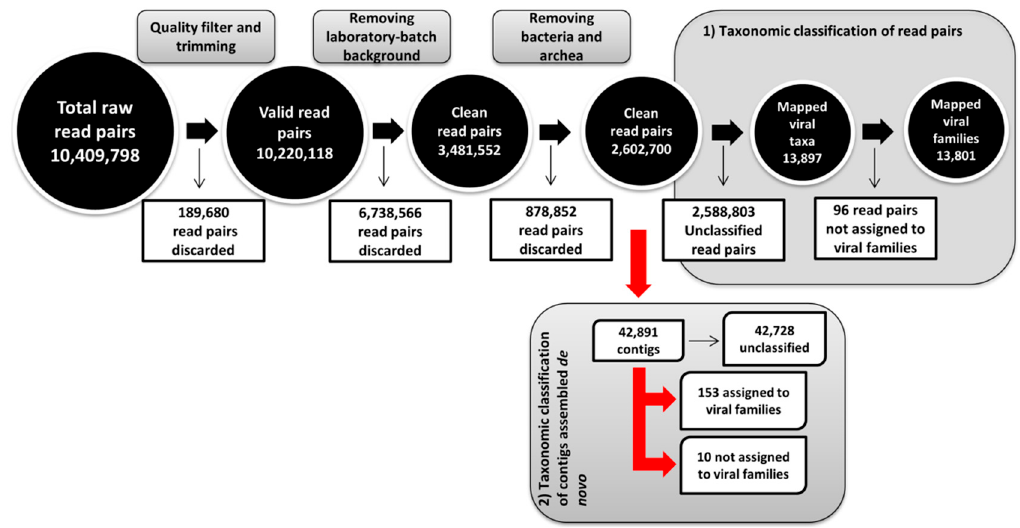
Figure 1. Next-generation sequencing (NGS) data analysis workflow. Metagenomic characterization workflow and taxonomic classification strategies of Illumina pair reads (1) and contigs assembled de novo (2). Pair reads quality filtering and trimming were performed with the bbduk program (BBTools v38.42). The centrifuge metagenomics classification system was used for the taxonomic classification of pair reads and contigs (Centrifuge version 1.0.3-beta) [43]. De novo assembly was performed using SPAdes v3.11 [45] and Unicycler. Table 1. Read pairs and contigs of virus families identified in anal and oral swab samples of Tadarida brasiliensis obtained by metagenomics using Illumina technology. No. of Read No. of Host Family Genome Type Pairs Contigs